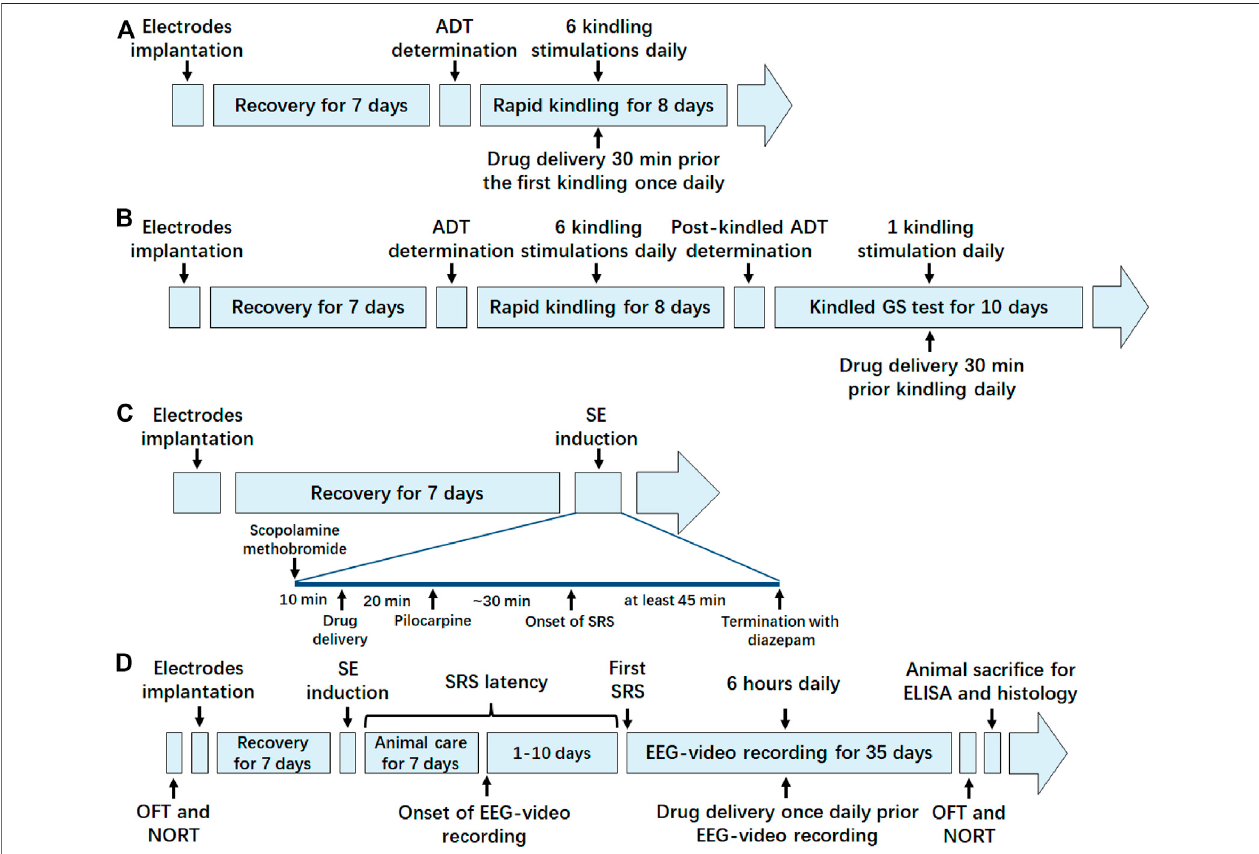
FIGURE1| Schematictimelinediagramofexperimentsineachanimalmodel. (A) Timelineoftheexperimentinhippocampalrapidkindlingmodel; (B) timelineofthe experimentinfullykindledmodel; (C) timelineoftheexperiment inpilocarpine-inducedSEmodel; (D) timeline oftheexperimentinpilocarpine-inducedSRSmodel.ADT, after discharge threshold; GS, generalized seizure; SE, status epilepticus; SRS, spontaneous recurrent seizure; OFT, open fi eld test; NORT, novel object recognization test; EEG, electroencephalograms; ELISA, enzyme linked immunosorbent assay.